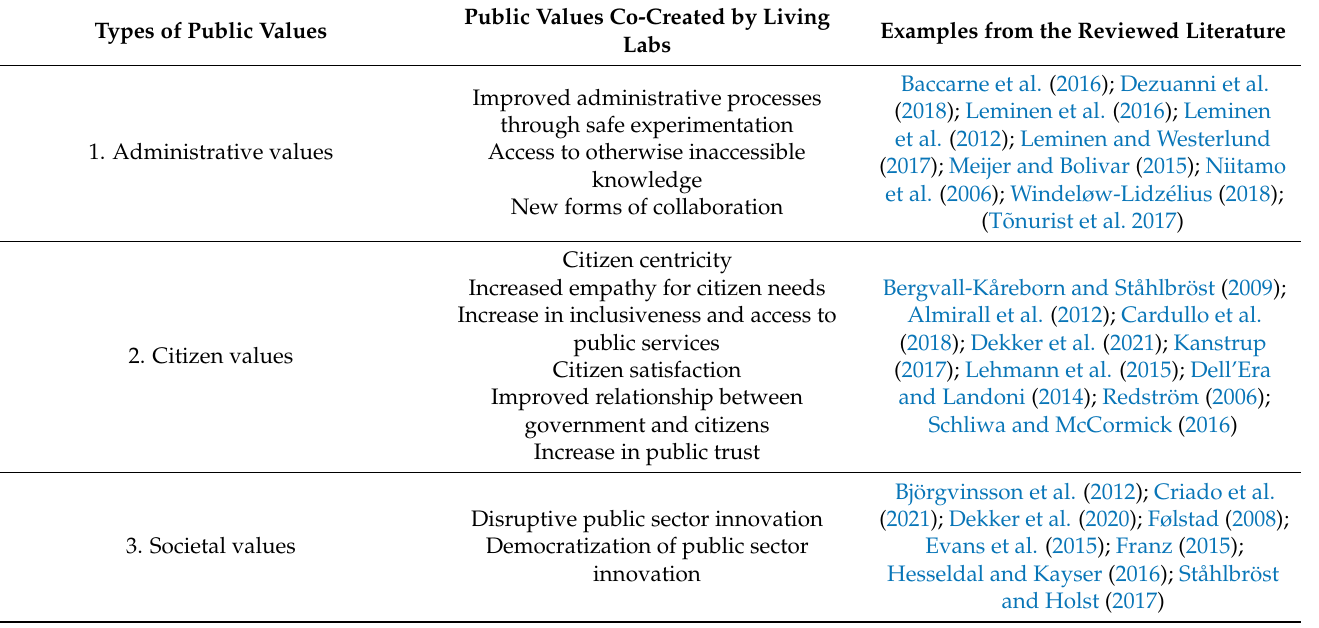
Table 3. Overview of public values co-created by living